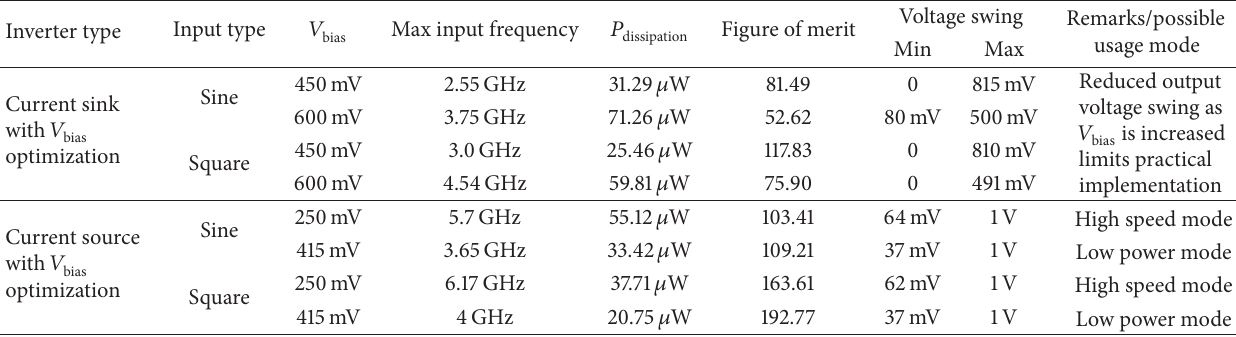
Table 4: Measured operating parameters of the optimized